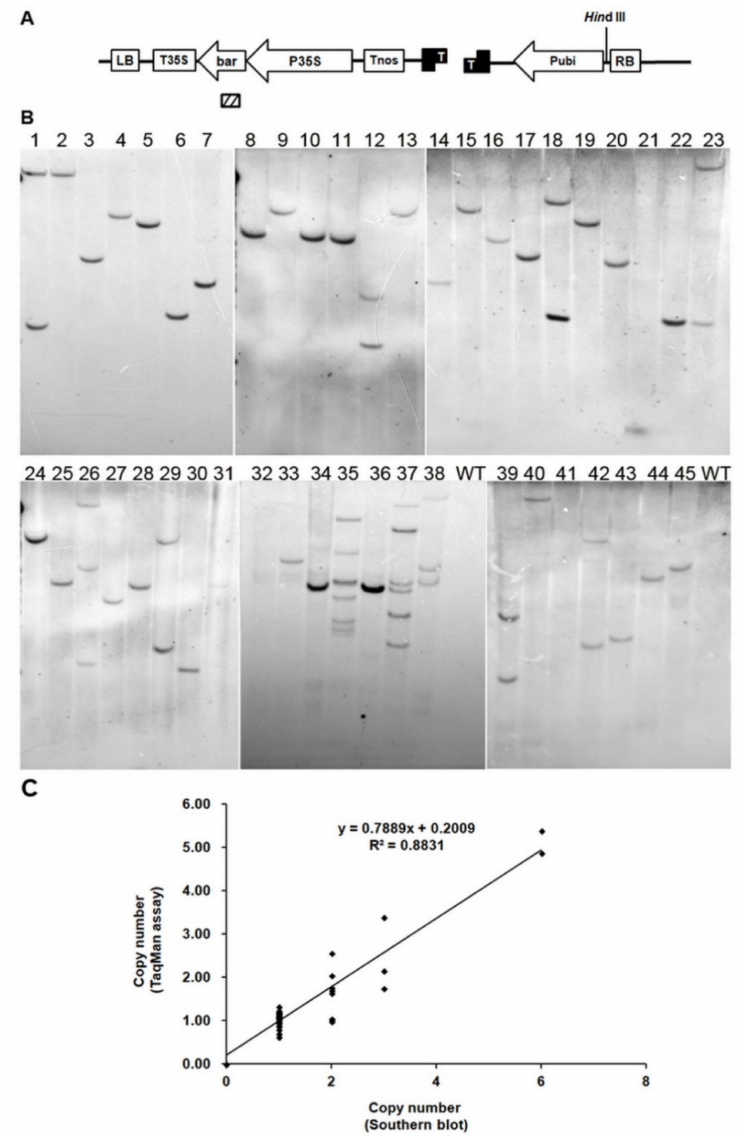
Figure 2. Correlation of TaqMan copy number assay data with Southern blot analysis. ( A ) Graphic representation of putative transgene insertion fragment (not to scale). pPBCXUN, binary vector construct in Agrobacterium strain EHA105 for Agrobacterium -mediated transformation; RB, right border; Pubi, ubiquitin promoter; Tnos, nopaline synthase terminator; P35S, 2 × CaMV 35S promoter; bar , phospinothricin acetyl transferase gene; T35S, CaMV 35S polyA; LB, left border. Position of Hin dIII restriction site is indicated above the T-DNA insert. Fragment used to generate bar -specific probes is indicated by the hatched box below bar gene. ( B ) Southern blot analysis of 45 independent T 0 transgenic maize plants. DNA samples from 45 T 0 events, as determined by TaqMan copy number assay, were digested with Hin dIII, fractionated by agarose gel electrophoresis, blotted to nylon, and probed with a bar -specific probe. Lines 1–45 correspond to 12141320, 12141321, 12151398, 12161497, 12161498, 12171579, 13181646, 13181668, 13191758, 13191764, 13191765, 13201829, 13201830, 12030065, 12050430, 12060607, 12060608, 12060612, 12060614, 12070775, 12080815, 12141331, 12161432, 12030070, 12040218, 12040220, 12050433, 12060625, 12060631, 12101014, 12111088, 12030068, 12030212, 12030213, 12030071, 12030210, 12030066, 12030067, 12010004, 12010005, 12030084, 12030085, 12030086, 12040234, and 12040236; WT represents untransformed ND101. ( C ) Correlation between copy numbers in transgenic maize T 0 lines determined by TaqMan assay and Southern blot